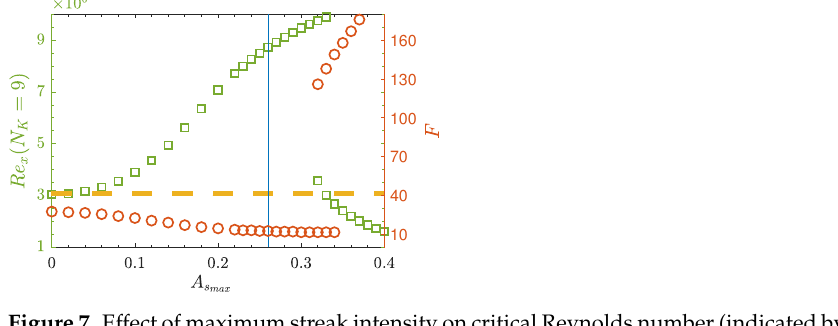
Figure 7. Effect of maximum streak intensity on critical Reynolds number (indicated by green squares) and critical frequency (denoted by red circles). Vertical thin line represents the streak amplitude from which the SI perturbations